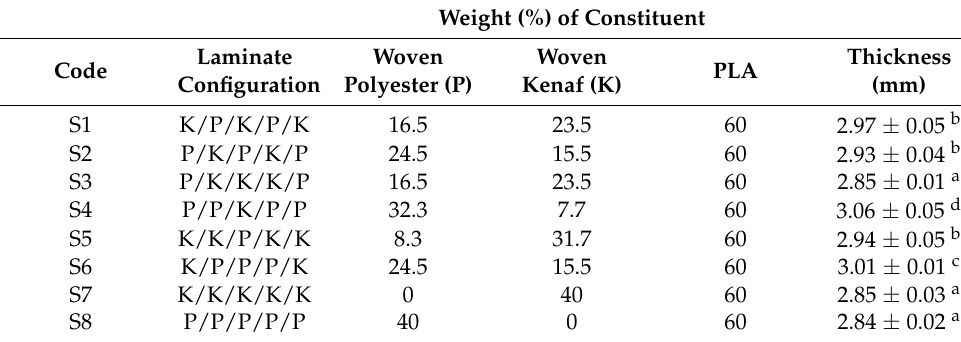
Table 2. Fiber matrix ratio and thickness of the laminated composites. Weight (%) of Constituent Code